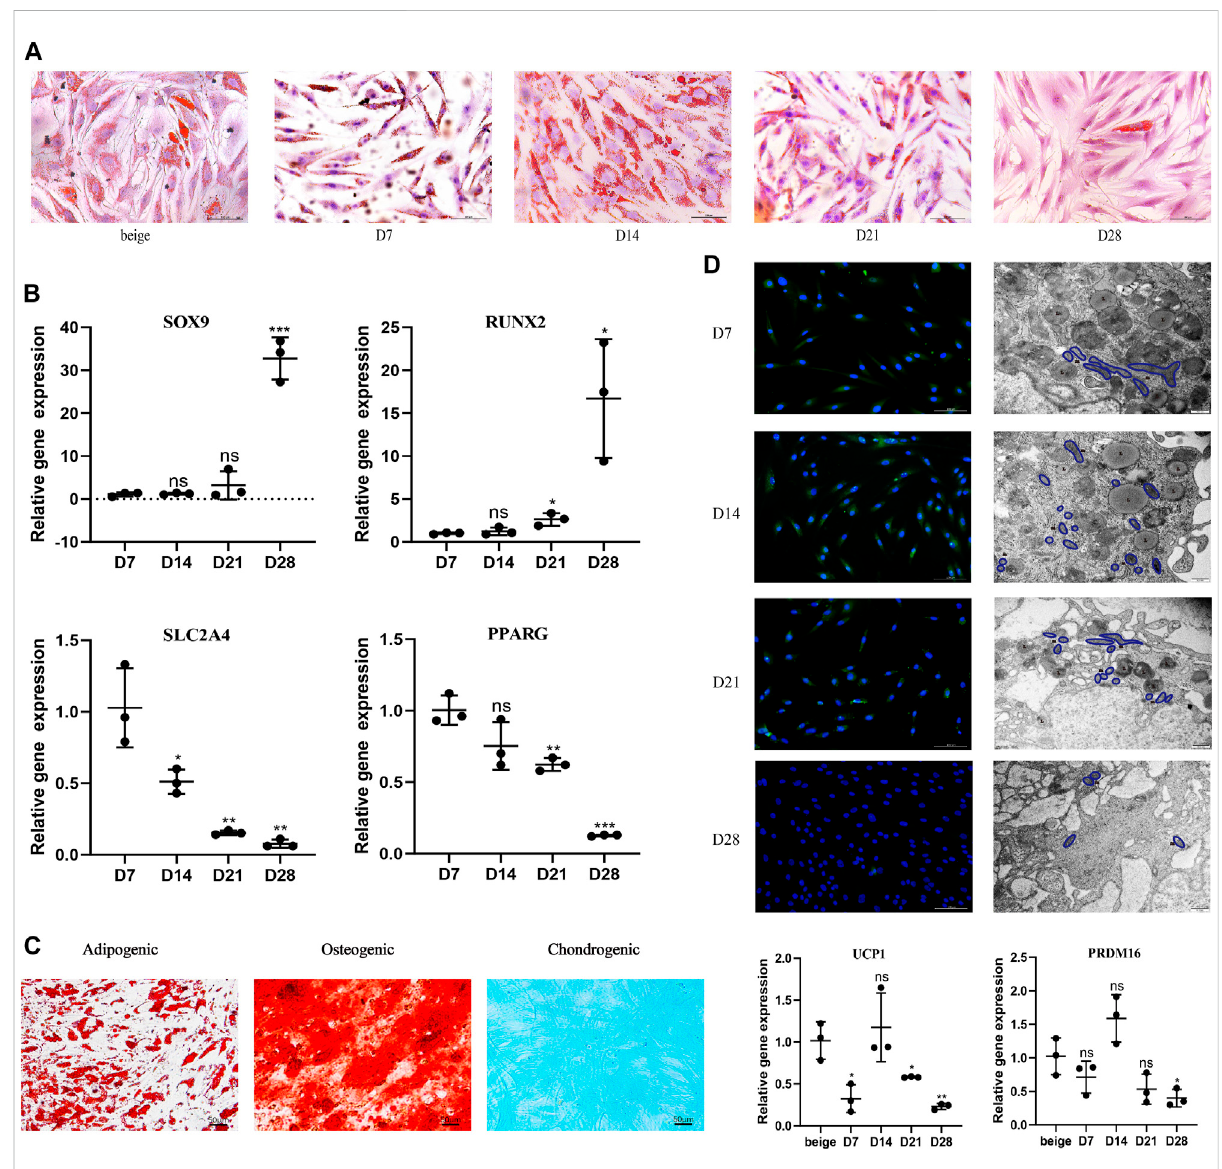
gene expression levels of SOX9 , RUNX2 , SLC2A4 , and PPARG , normalized to GAPDH as an endogenous control. (C) Human dedifferentiated adipocytes(DAs)wereculturedfor3